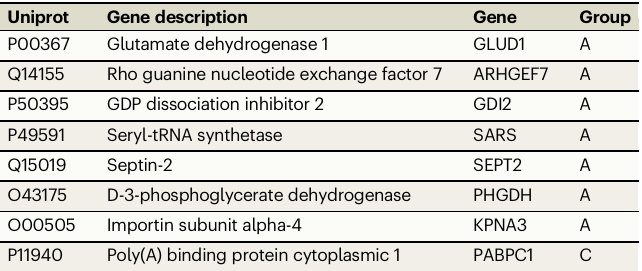
Table 3 | Proteins associated with favorable prognostic in glioma and identi fi ed in regions A, B, and